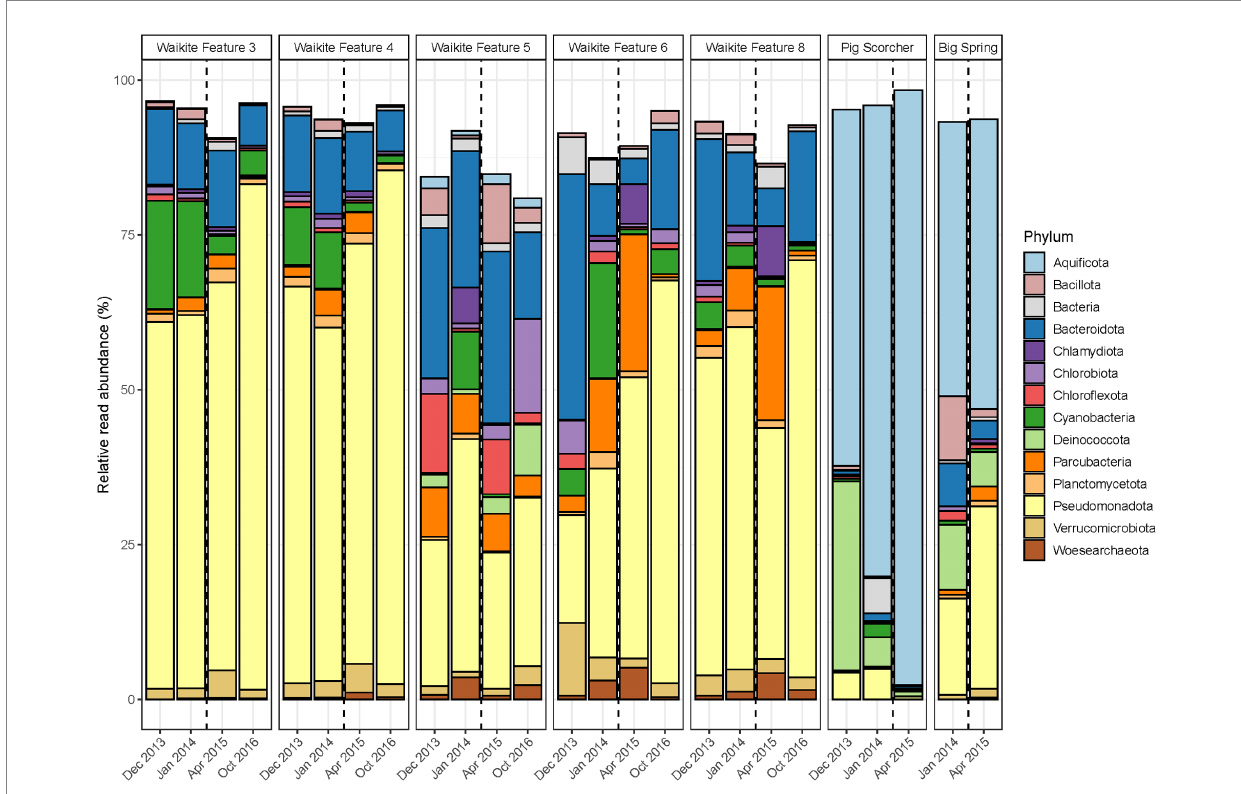
FIGURE 4 Temporal microbial community composition and relative abundance of geothermal features during the Waikite wetland restoration. Amplicon sequencing of the 16S rRNA gene was used to measure read abundance of taxa in spring communities, with only phyla >1% average relative abundance across all samples in this category shown. The vertical dashed line indicates the construction of a weir near the outlet of the